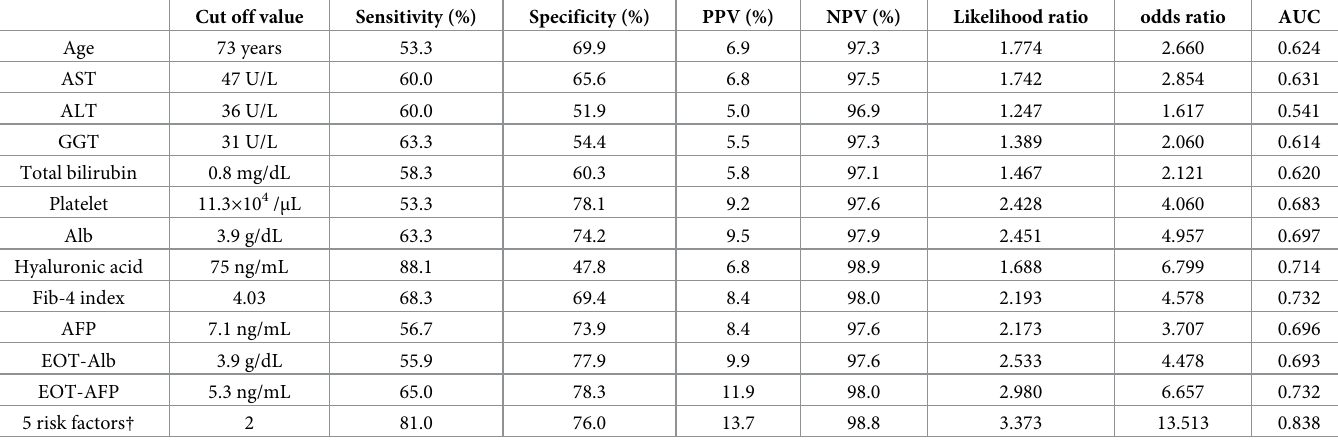
† The sum of scores when EOT-AFP � 5.3 ng/mL was scored as 2 points; the others (i.e., age � 73 years, male sex, hyaluronic acid � 75 ng/mL, and EOT-Alb < 3.9 g/dL) were scored as 1 point.